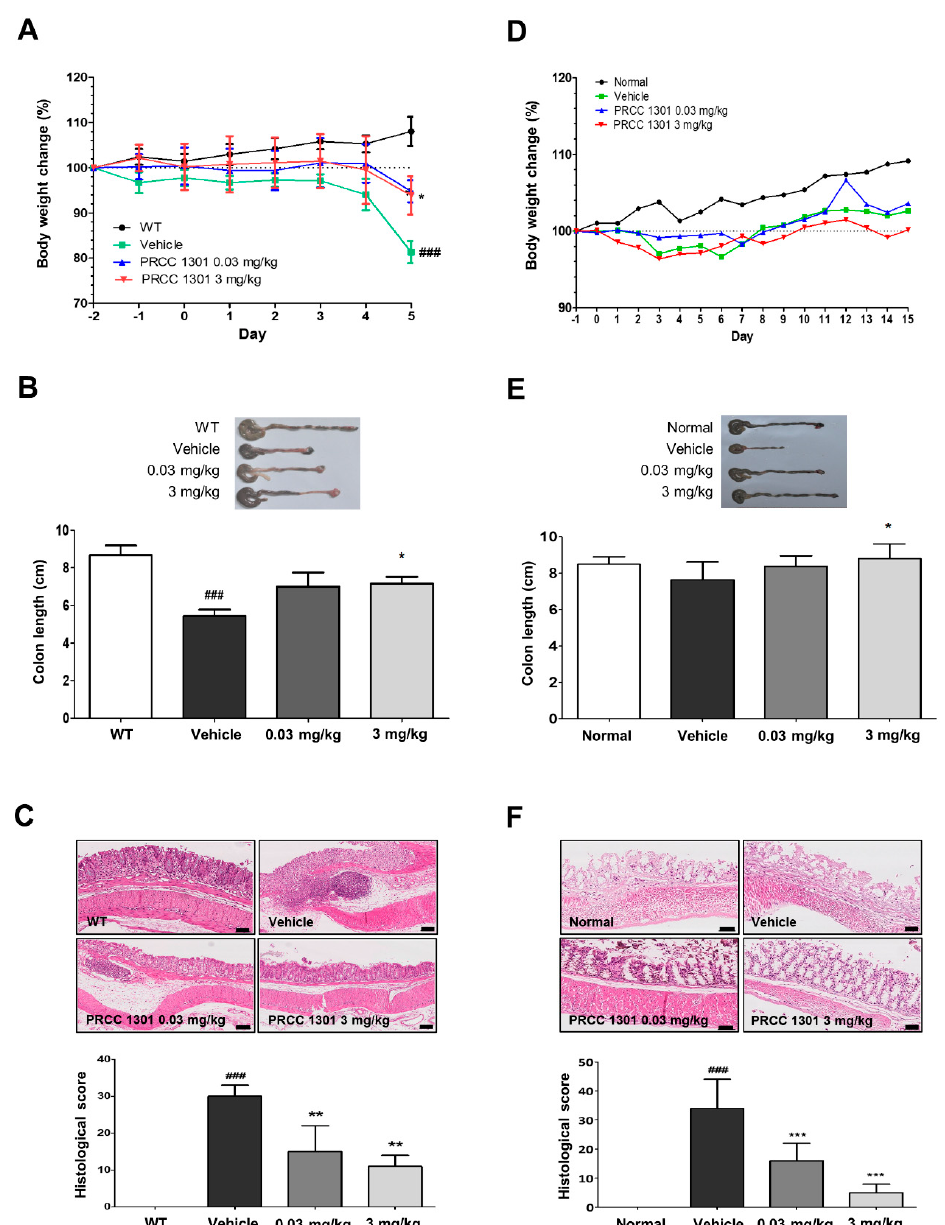
Figure 3. PRCC-1301 EVs prevented DSS-induced acute colitis and attenuated chronic colitis in IL10 - / - . ( A , D ) Body weight, ( B , E ) colon length, and ( C , F ) histological evaluation in DSS-induced and IL10 -/- colitis, respectively. The results are shown as mean ± SEM. ### p < 0.001 compared with wild-type (WT), * p < 0.05, ** p < 0.01, and *** p < 0.001 compared with vehicle group. Scale bar = 100 μ m.